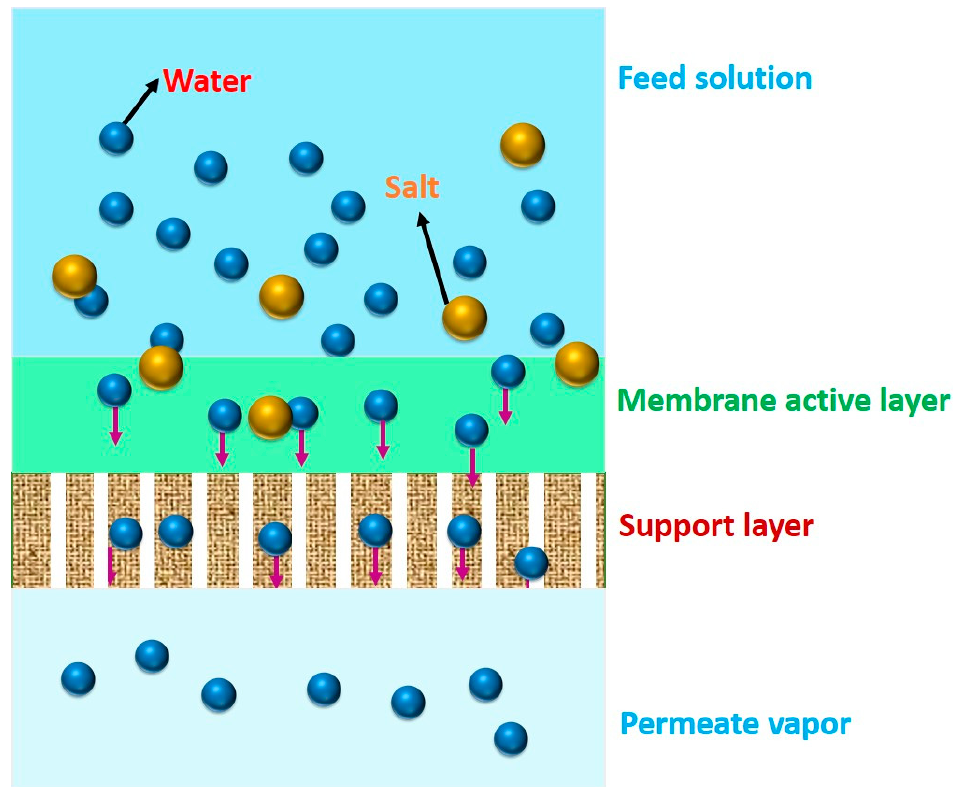
Figure 2. Desalination by the PV process where water passes through a dense PV membrane.